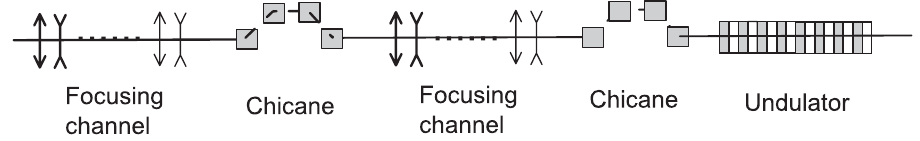
FIG. 1. Conceptual scheme of an LSC